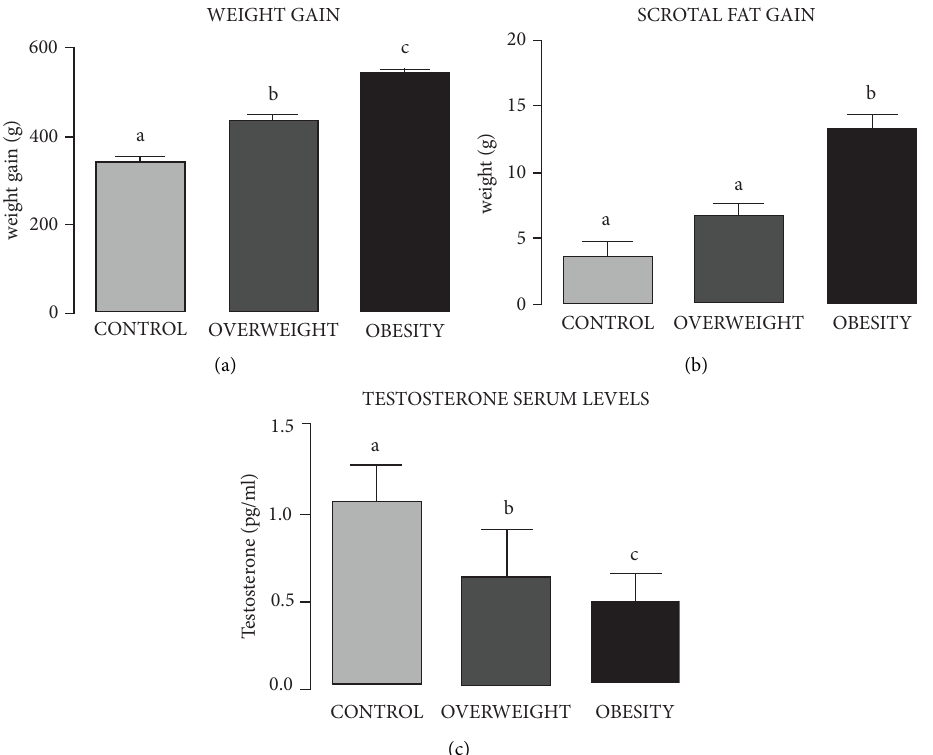
Figure 1: Weight gain, scrotal fat gain, and testosterone serum levels in Wistar rats fed for four weeks with regular chow (control group (CN)) or hyperlipidemic diets with 10% (overweight group (OW)) and 60% fat (obesity group (OB)). Bars represent mean ± SD. Letters indicate significant differences between groups, P < 0 . 05 (CN vs. OW vs. OB).